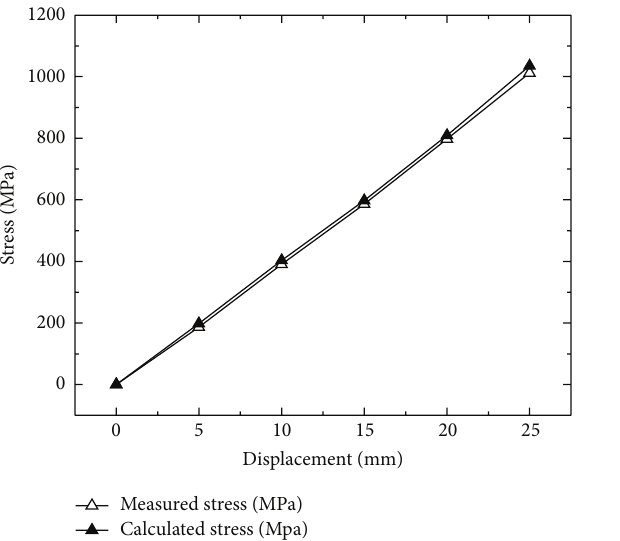
Figure 5: Direction of the applied forces and location of the strain gauges and position of the measured stress on toroidal